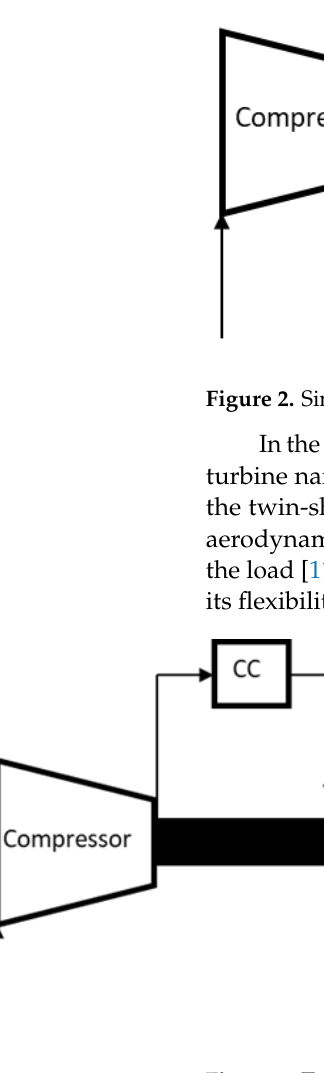
Figure 3. Twin-shaft GT cycle.